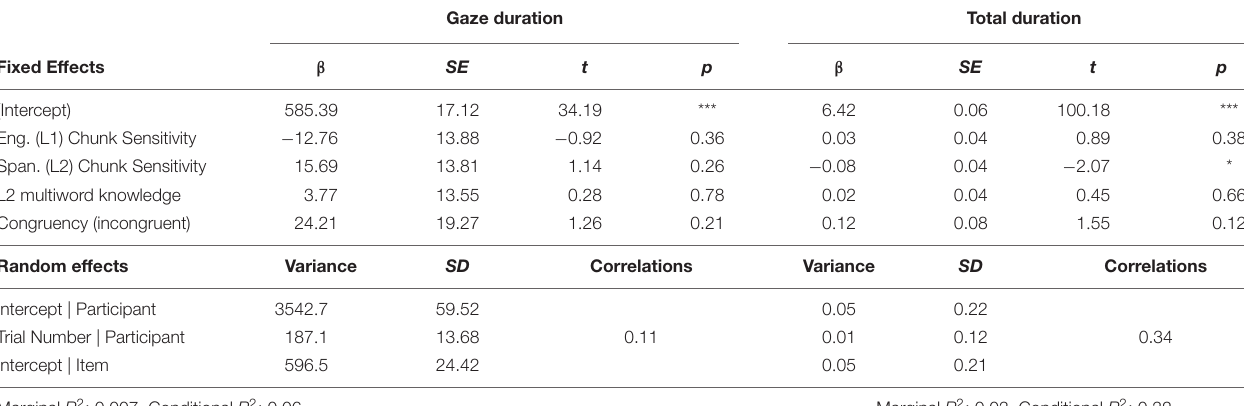
TABLE 3 | Summary of selected models for the noun region.